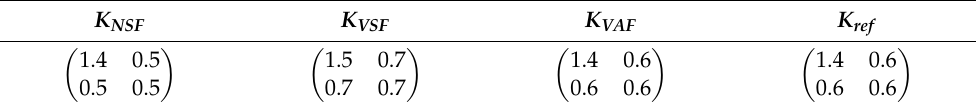
Table 7. Hydraulic conductivity tensors computed on the networks displayed in Figure 25. K NSF K